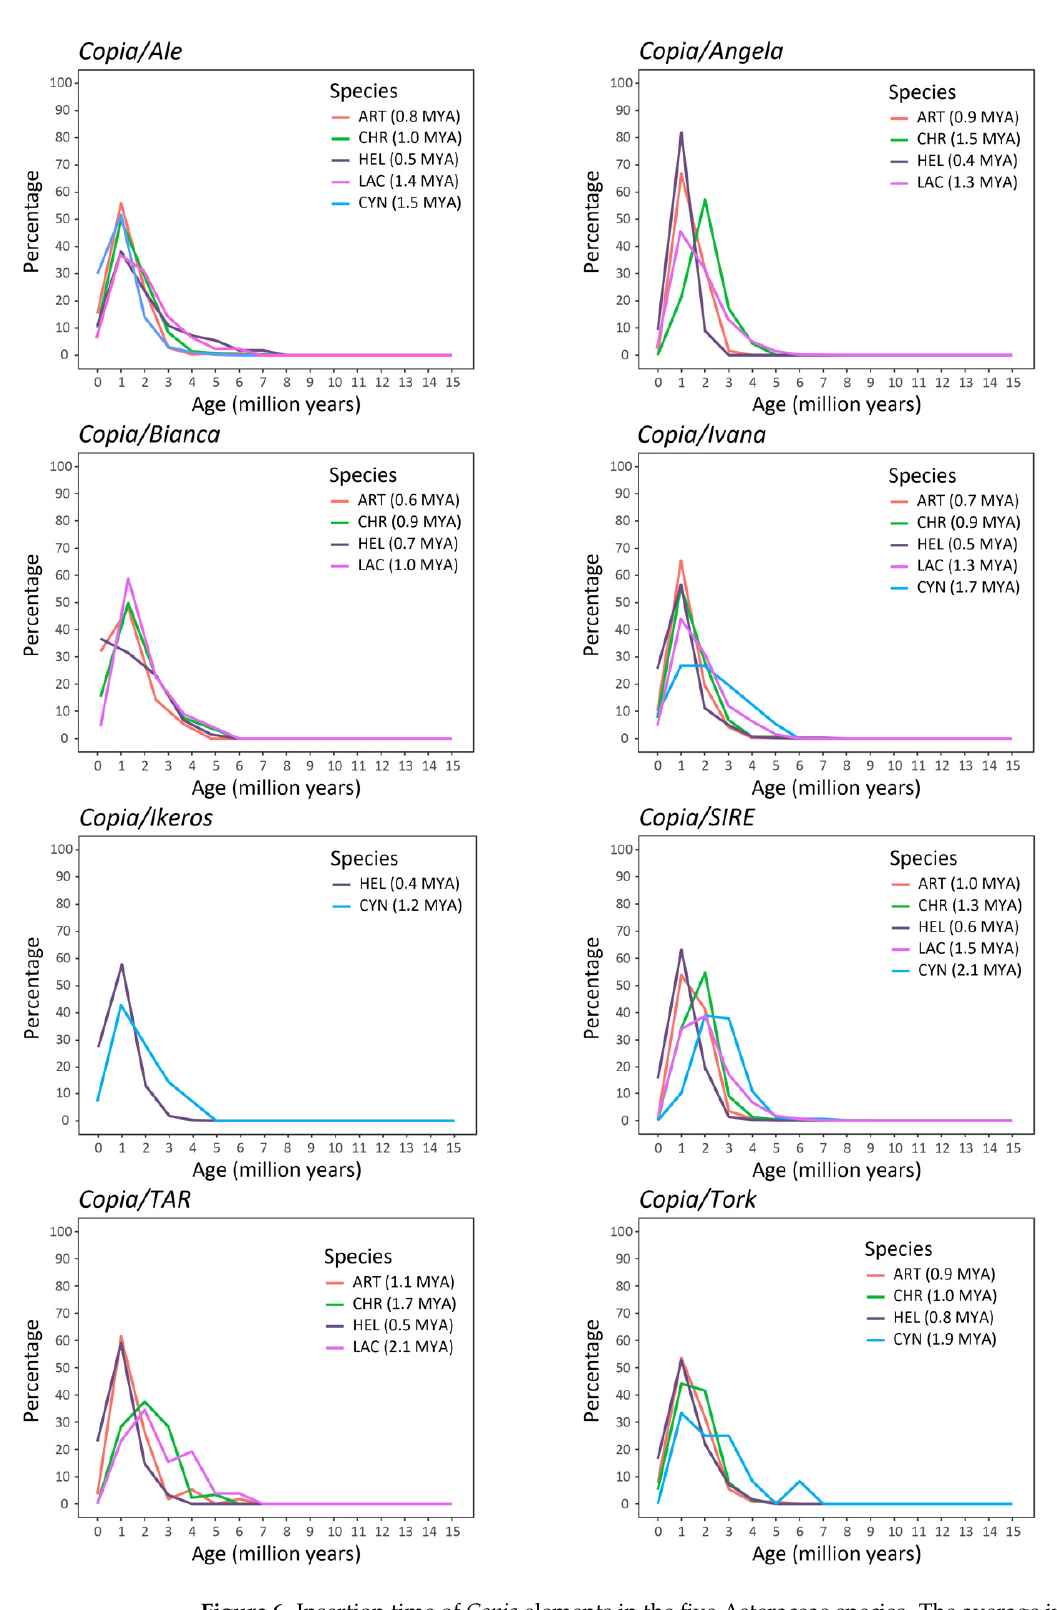
Figure 6. Insertion time of Copia elements in the five Asteraceae species. The average insertion time (in MYA) for each species is reported in parentheses. HEL = Helianthus annuus , LAC = Lactuca sativa , CYN = Cynara cardunculus var. scolymus , ART = Artemisia annua , CHR = Chrysanthemum seticuspe.